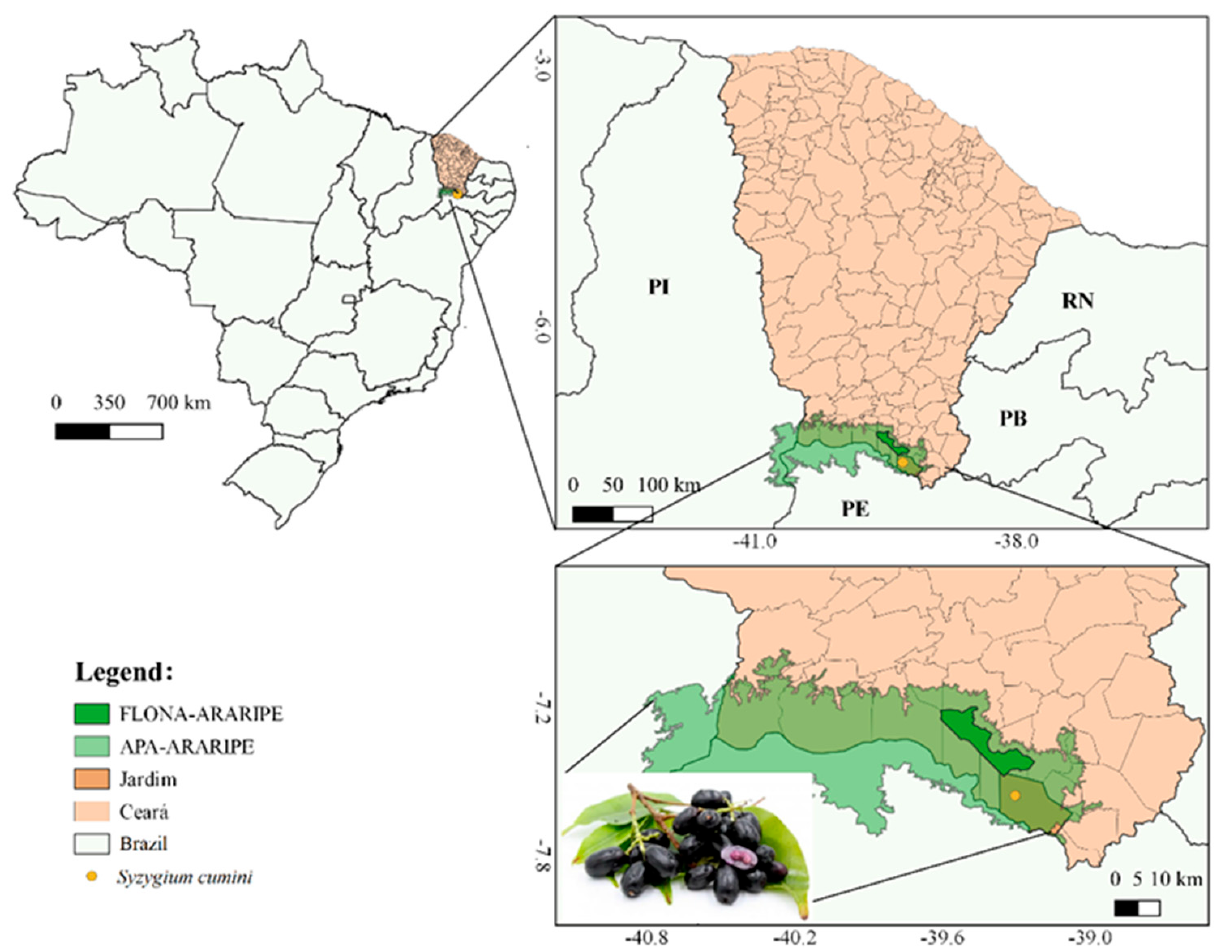
Figure 2. Location map of Syzygium cumini leaves collection in Serra Gravatá, municipality of Jardim, Ceará, Brazil.